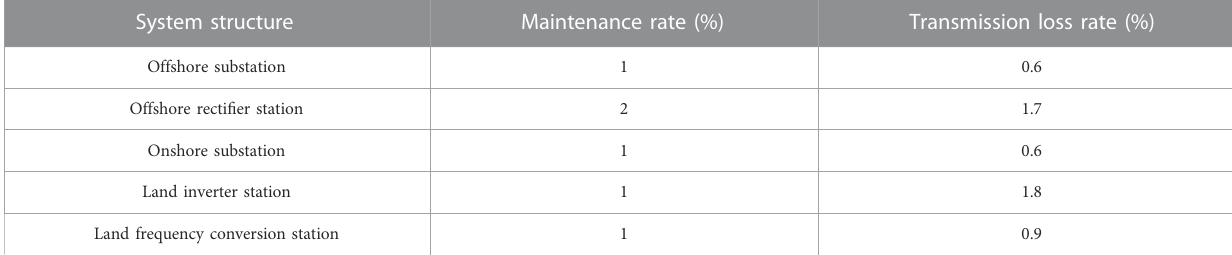
TABLE 5 Transmission loss rate of each